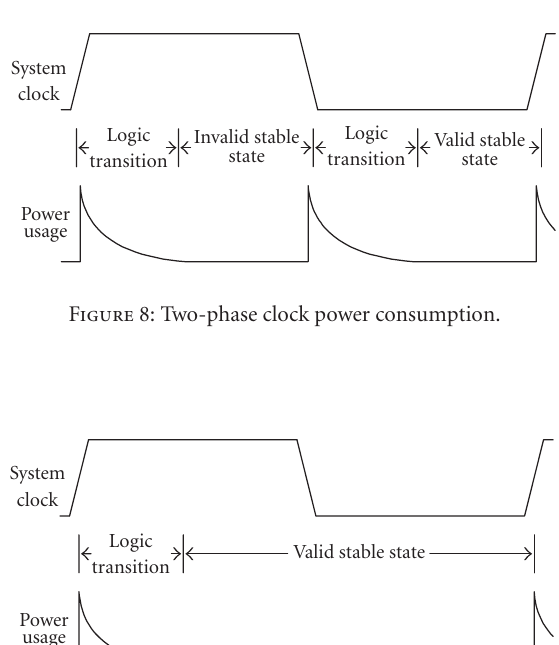
Figure 5: Screen copy and micrograph of the 2DLNS filterbank.